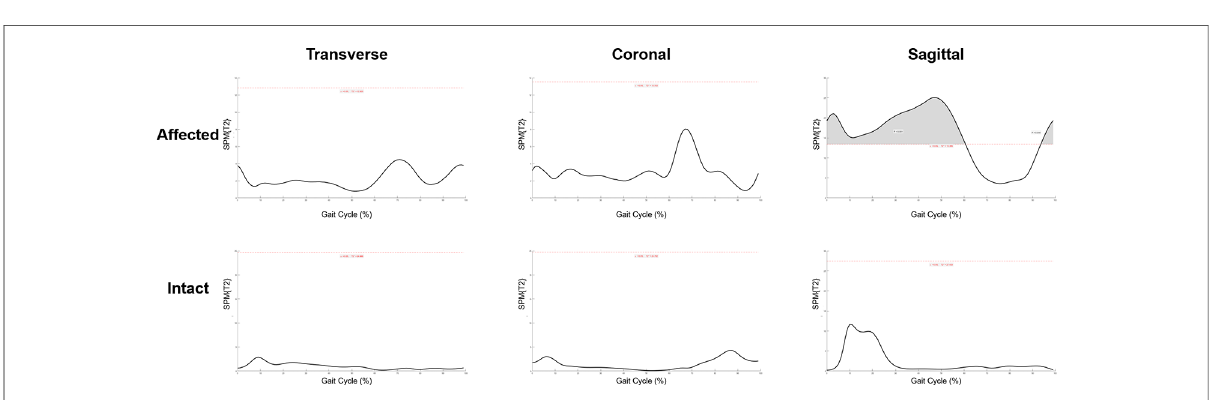
FIGURE 4 Statistical parametric mapping Hotellings2 tests of pre-operational and post-operational kinematic curves in both affected and intact sides at transverse, coronal and sagittal plane. Grey region above the red dash line: statistical signi fi cance